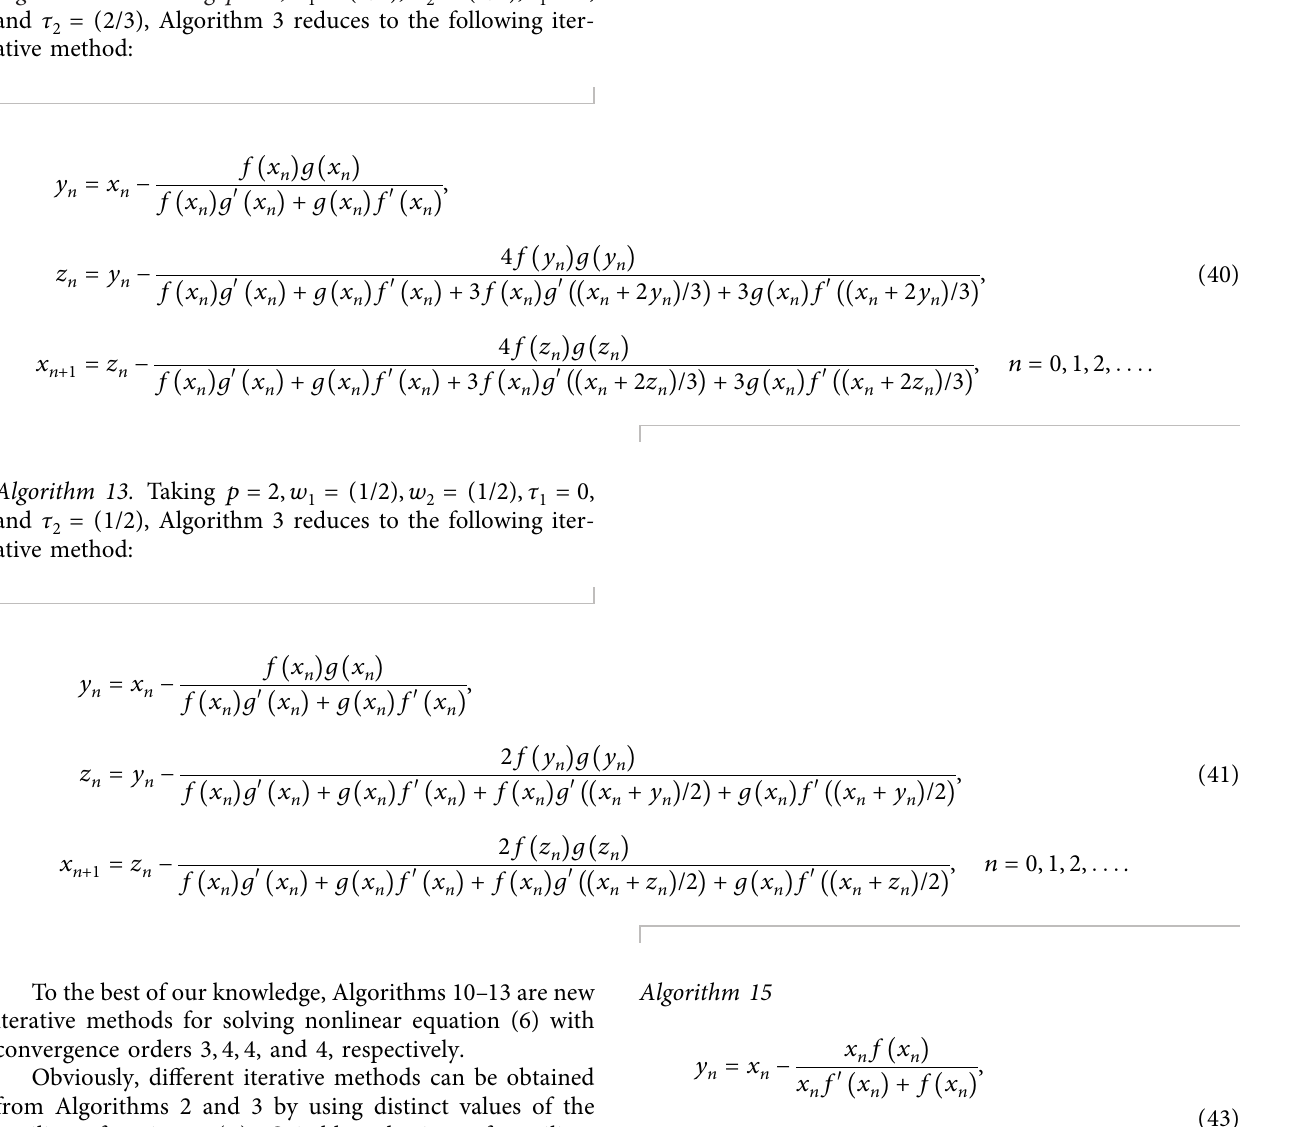
Algorithm 12. Taking p � 2 , w